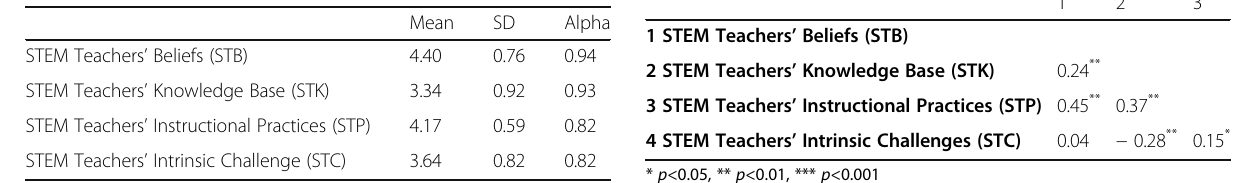
Table 3 Description statistics and reliability coefficient for each subscale ( n = 216)